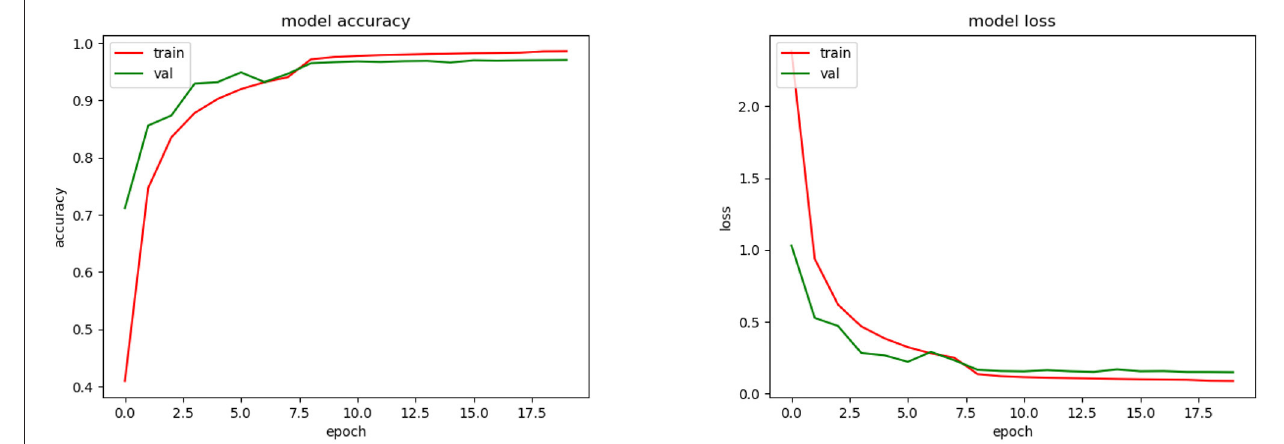
FIGURE 9 | Training accuracy and loss for CNN model with SSPB bias.